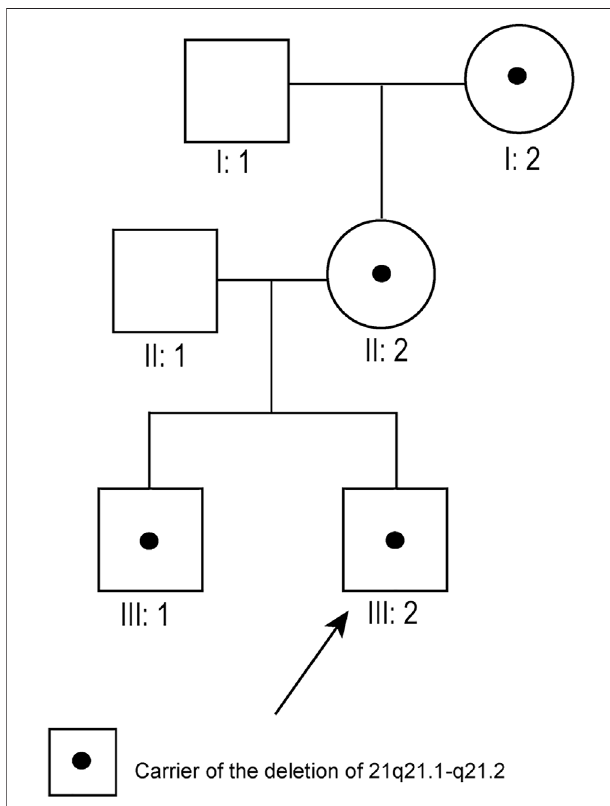
FIGURE 1 | Pedigree diagram of pedigree 7 (arrow indicates the fetus). The fetus ’ s maternal grandmother, mother, and brother all carried the 21q21.1 – 21.2